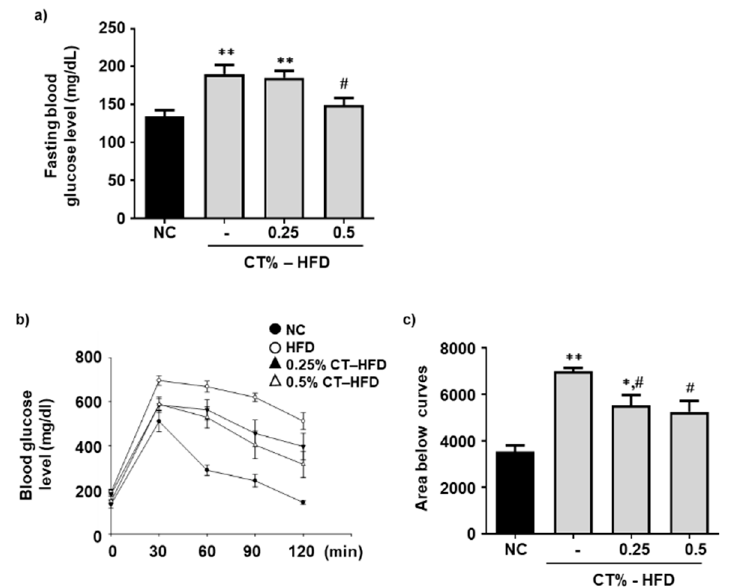
Figure 3. Effect of CT treatment on serum glucose level and glucose tolerance. One week after acclimatization, C57BL/6J mice were fed HFD mixed with 0.25% and 0.5% CT for 7 weeks. ( a ) At 6 weeks of treatment, blood glucose levels were measured in mice fasted overnight (NC group: n = 4; HFD only, 0.25% and 0.5% treated with HFD group: n = 8). ( b ) Glucose tolerance test of all group was performed. ( c ) Area below curve were plotted. NC: normal chow; (-): HFD; CT-HFD; CT treated HFD. Values are mean ± SE. AVOVA p -value: ** <0.01, * <0.05 vs. NC group; # <0.05 vs. HFD-fed group.